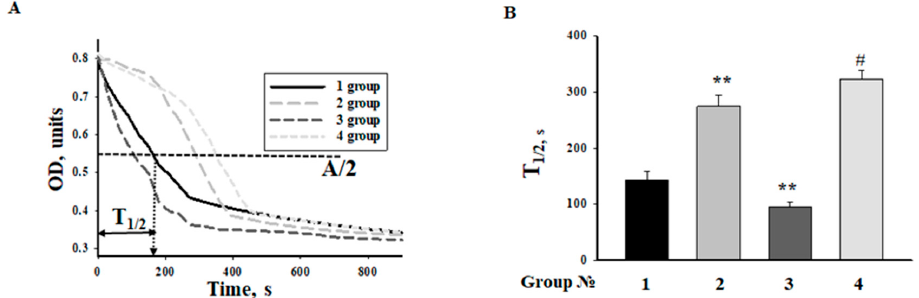
Figure 5. Ca 2+ -dependent swelling of RHM from rats of each group upon mPTP opening. RHM were incubated in standard medium as described in Methods. Group 1: Control animals, Group 2: animals treated with MEL (~7 mg/kg of body weight per day), Group 3: animals treated with ISO (85 mg/kg of body weight twice), Group 4: animals treated with MEL + ISO. ( A ) Curves of RHM swelling. ( B ) Average half-times (T 1/2 ) of swelling. T 1/2 was calculated as shown on Panel A. ** p ≤ 0.01 vs. the T 1/2 of mitochondria from control rats (group 1), # p ≤ 0.05 compared with the T 1/2 of mitochondria from animals treated with ISO (group 3).